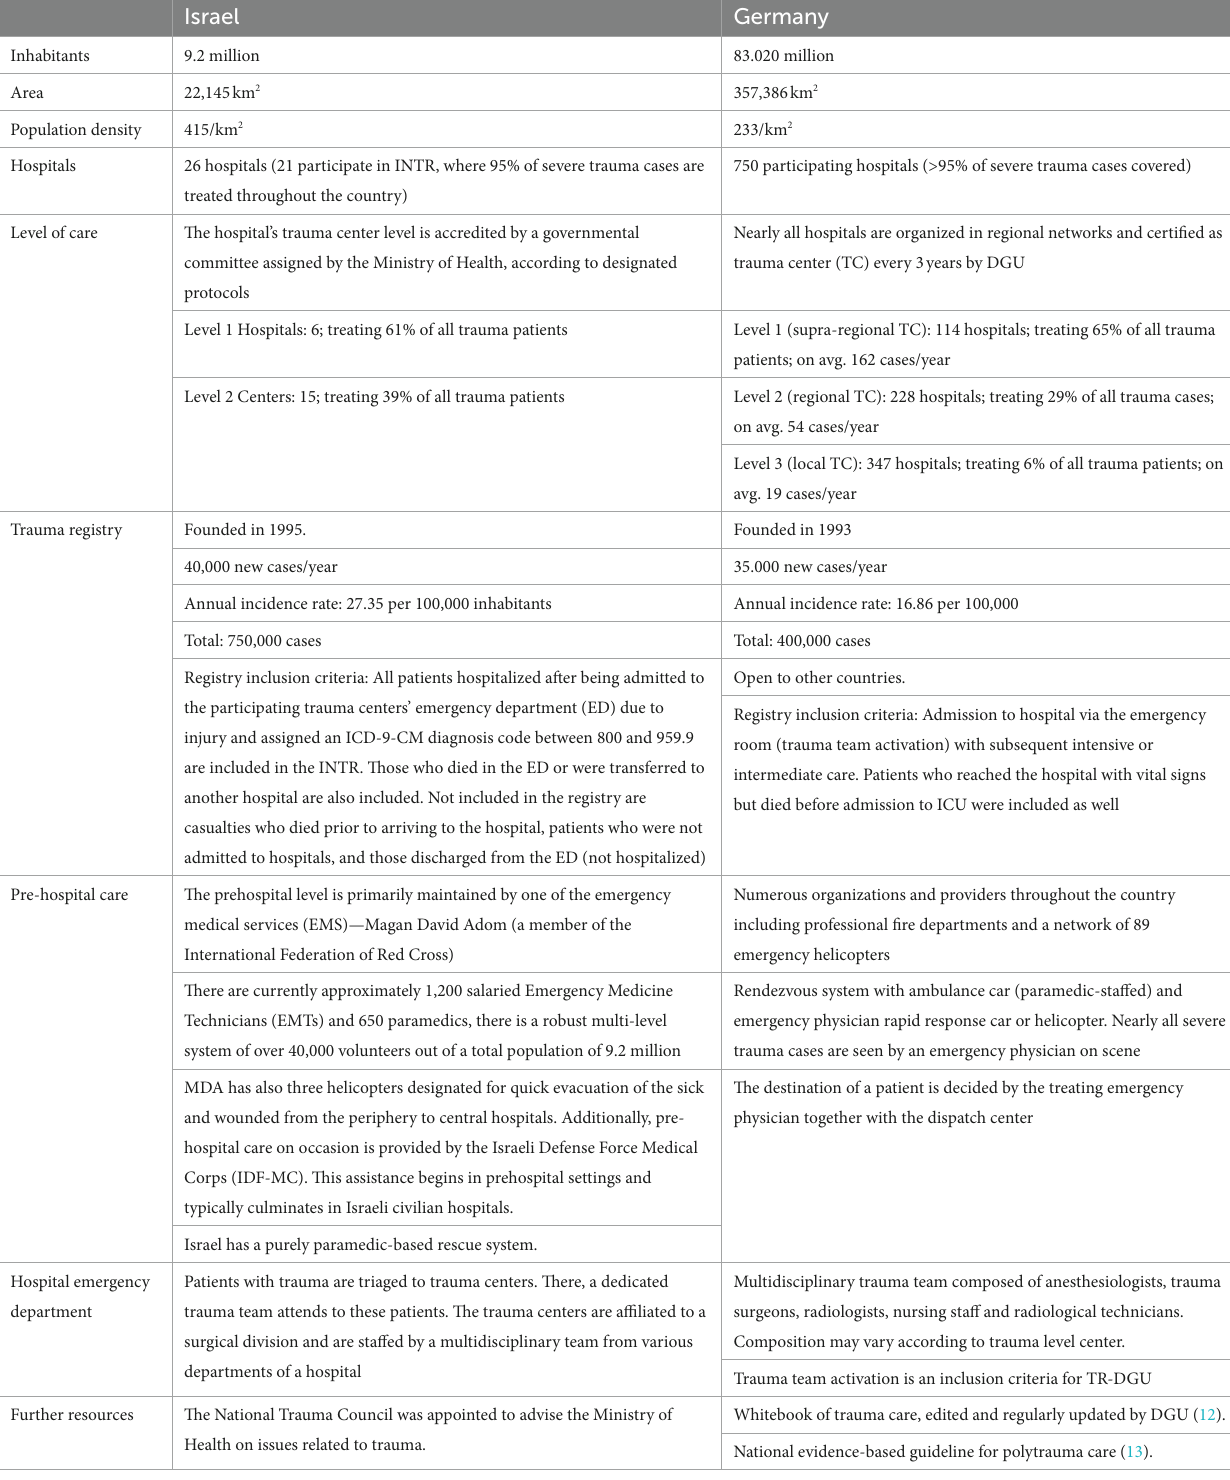
TABLE 1 Description of organization of emergency care in Germany and